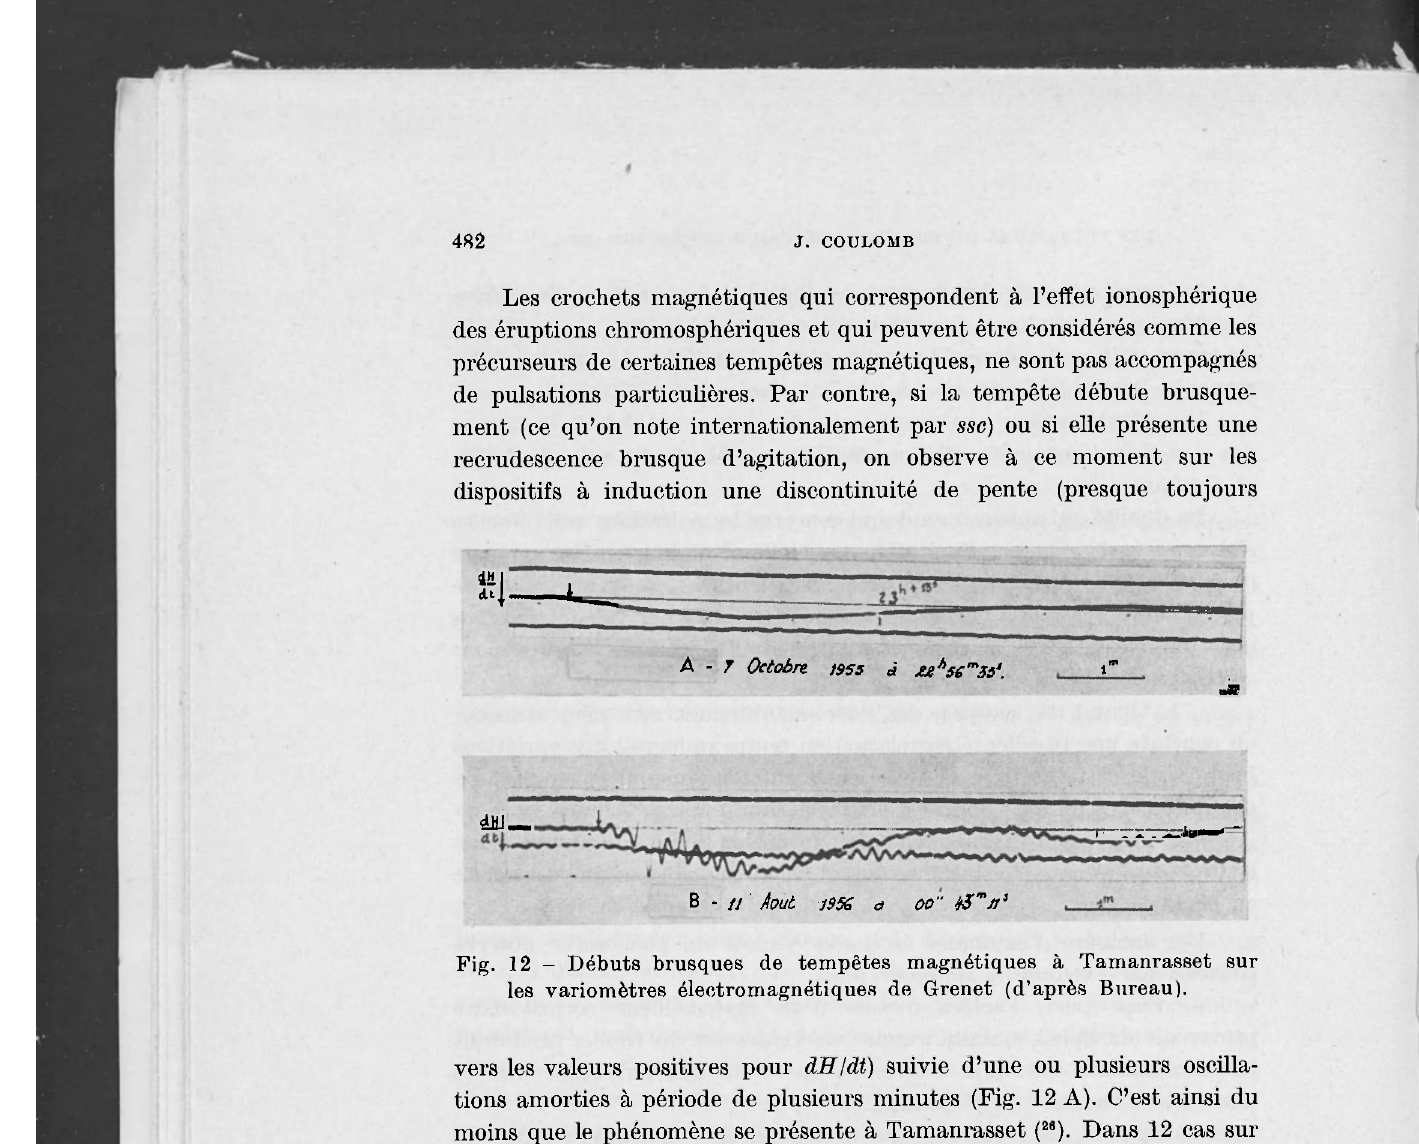
Fig. 12 - Débuts brusques de tempètes magnétiques à Tamanrasset sur les variomètres électromagnétiques de Grenet (d'après